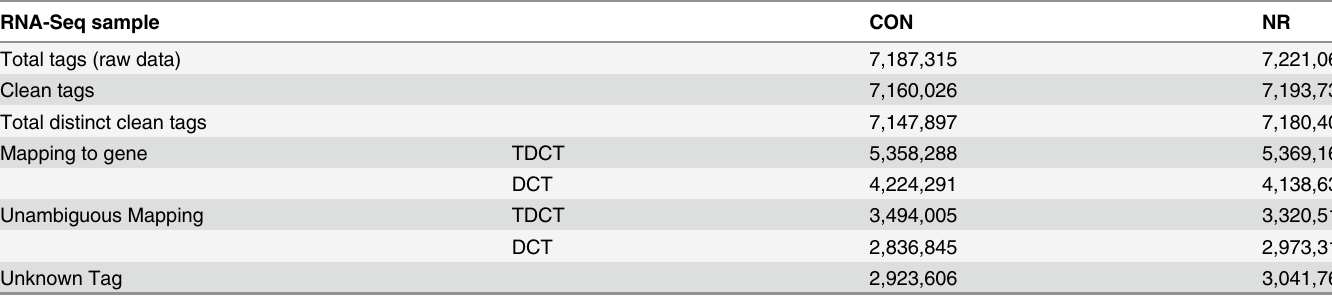
Table 4. RNA-Seq data summary and tag mapping to the UniGene transcript database. RNA-Seq sample CON